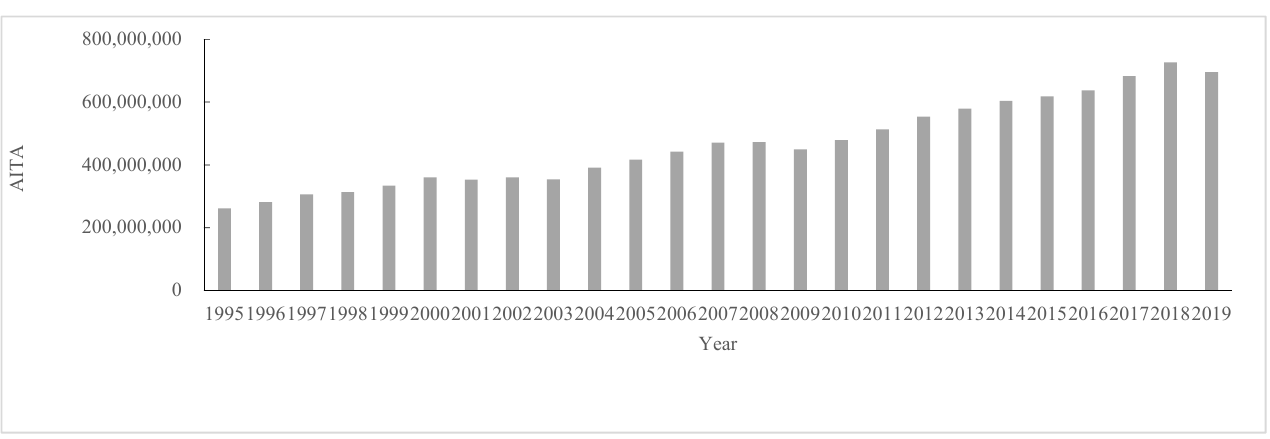
Figure 5. The outcomes of AITA from 1995 to 2019.